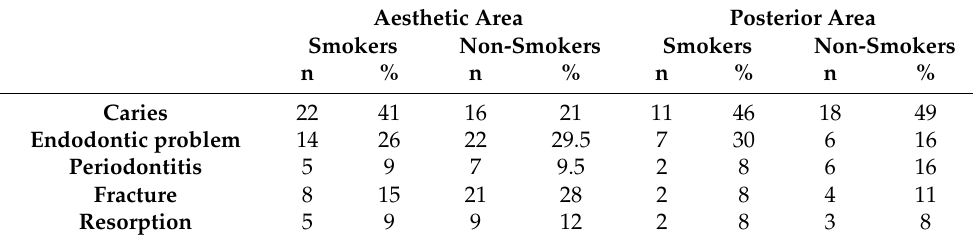
Table 2. Reasons for tooth